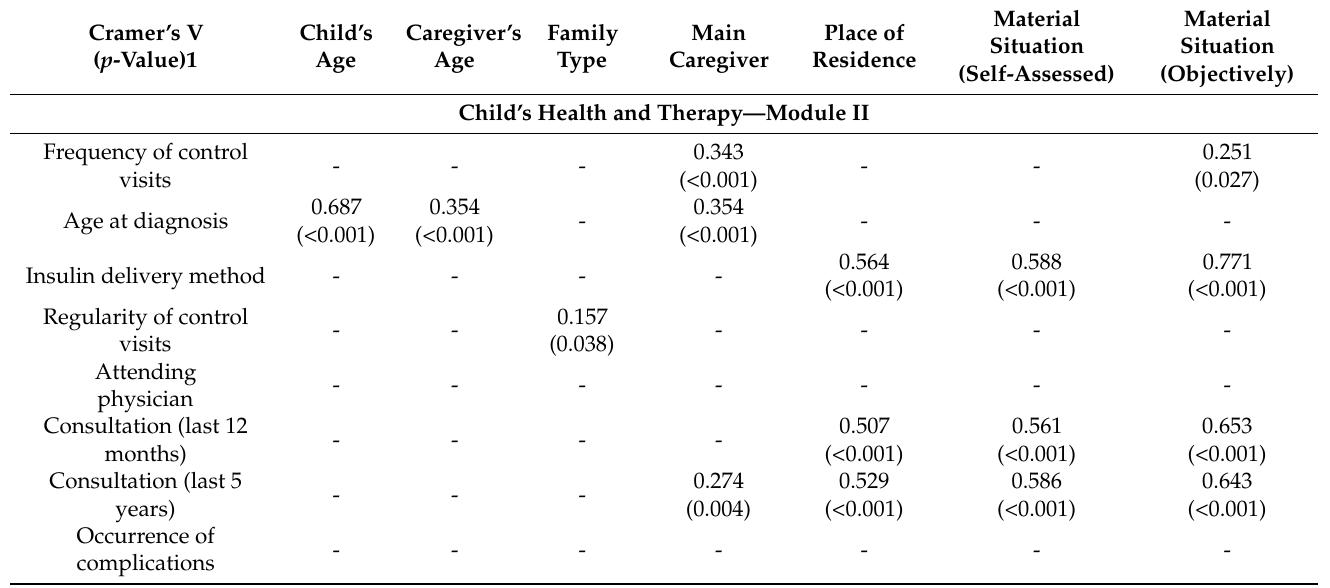
Table 2. Correlation between demographic factors and health